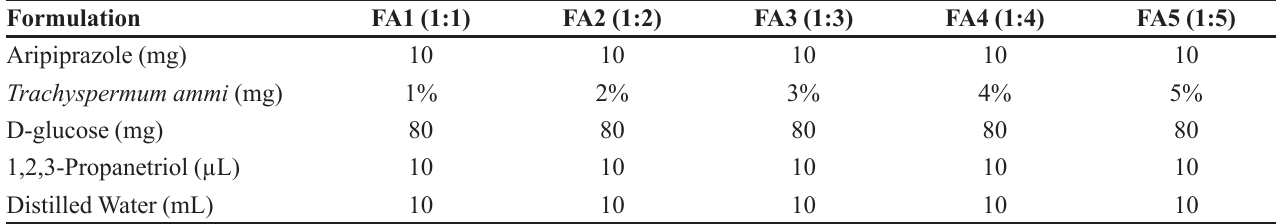
TABLE I - Formulation table of optimized aripiprazole loaded bio-flexy films of Trachyspermum ammi Formulation